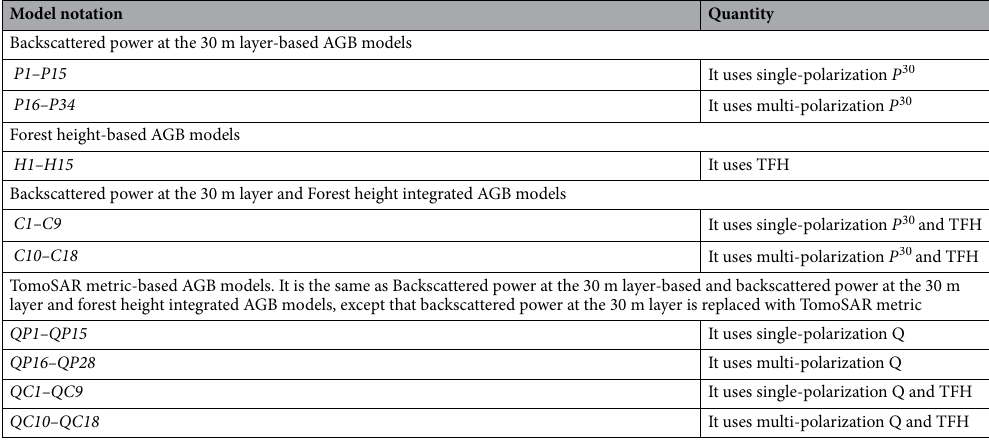
Table 2. Summary of AGB models using different TomoSAR